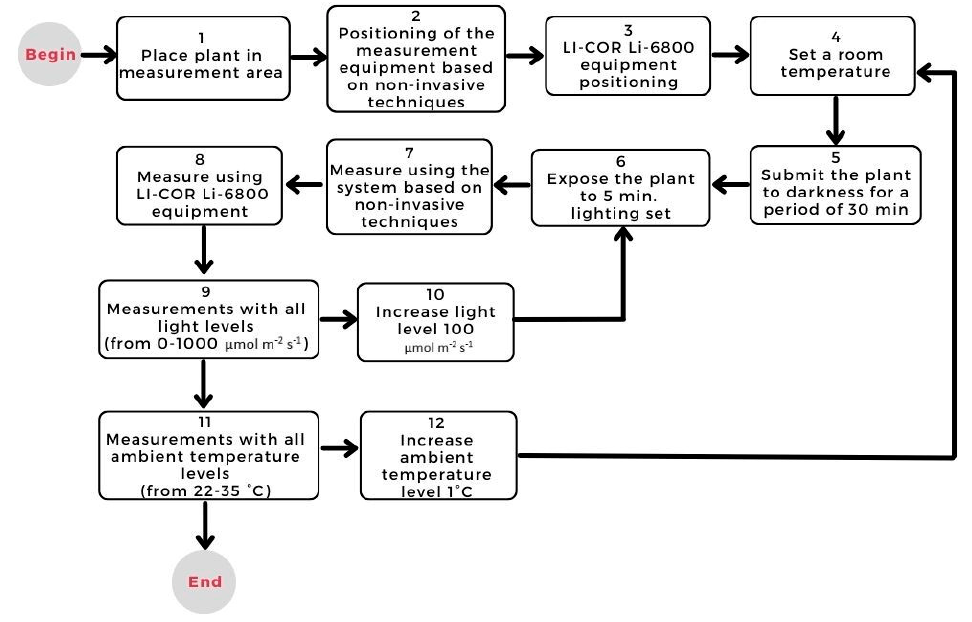
Figure 2. Plant experimentation methodology.